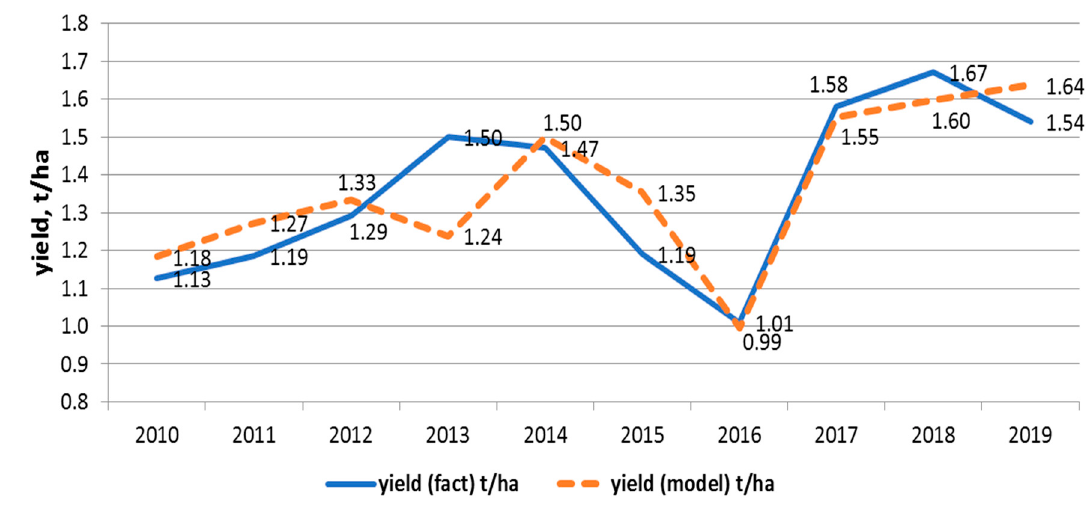
Figure 10. Actual and calculated soybean yield (t / ha) in the Khabarovsk District, 2010–2018.